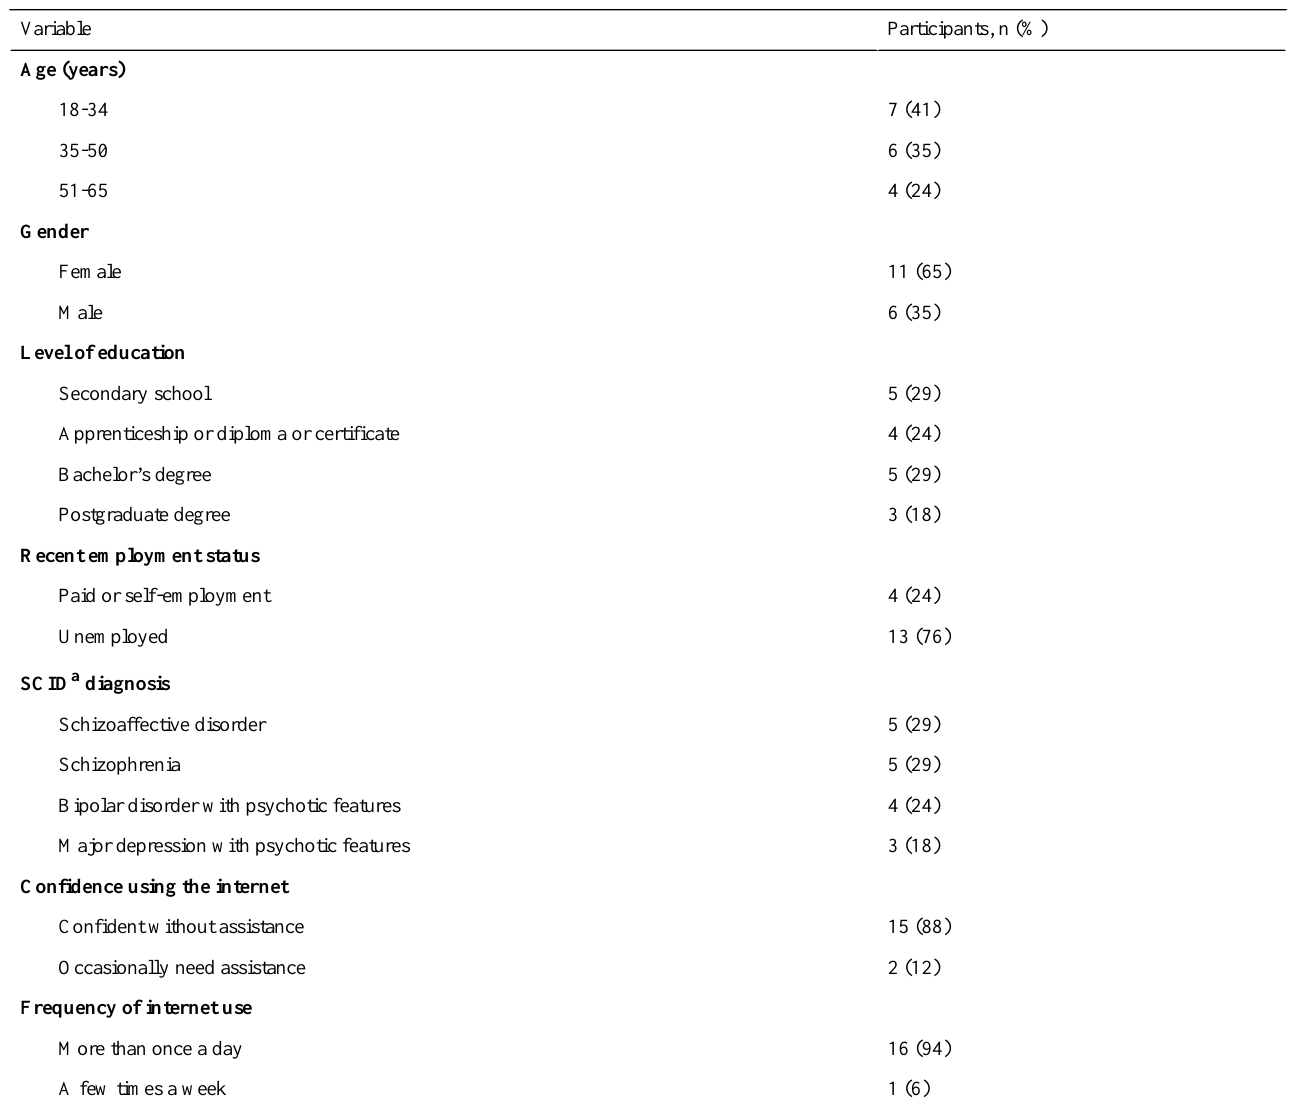
Table 1. Participant characteristics